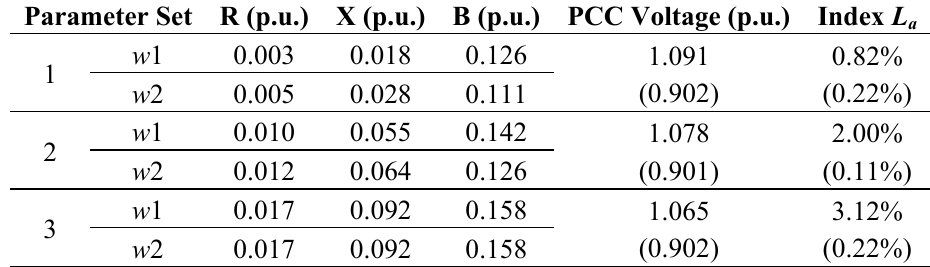
Table 1. Line parameters (p.u.) with corresponding PCC voltages and values of the linearity index